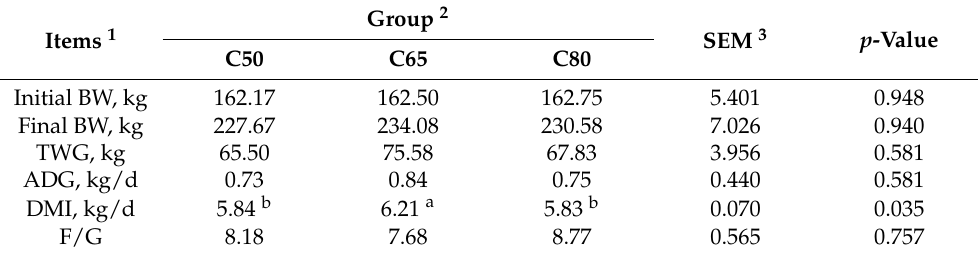
Table 2. Effects of dietary Concentrate and Forage on growth performance of Yak.